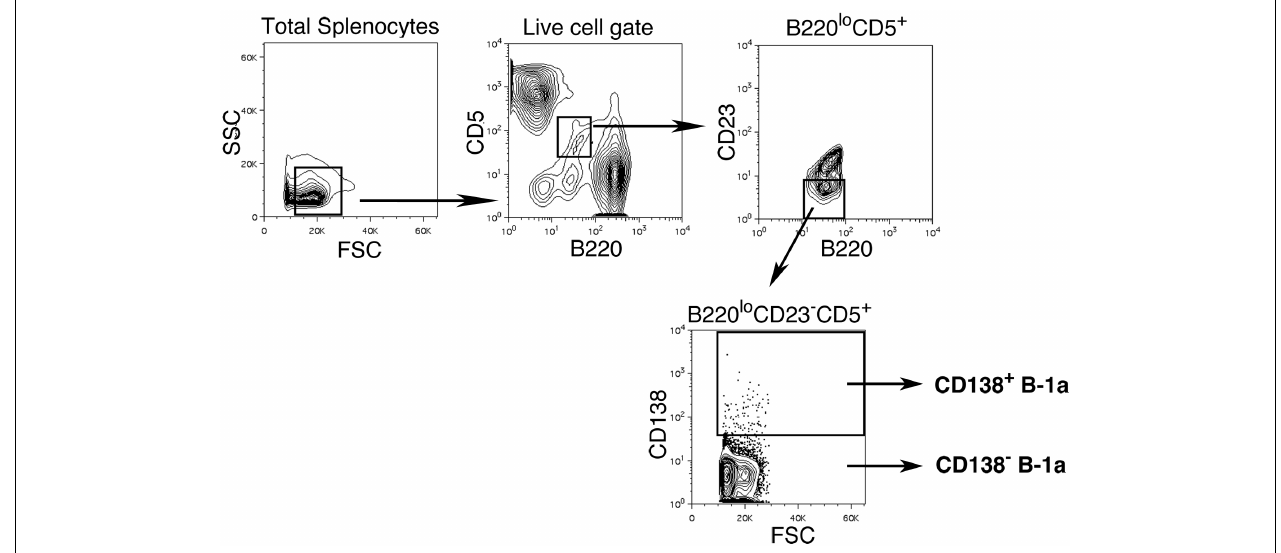
FIGURE 1 | Gating strategy for CD138 + and CD138 − splenic B-1a cells in naïve non-immune mice. Single cell suspensions of RBC lysed spleens from BALB/c-ByJ mice were prepared and stained with B220-FITC, CD5-PE-Cy5, CD23-Pacific Blue, and CD138-PE. Splenic CD138 + and CD138 − B-1a cells were gated as shown and